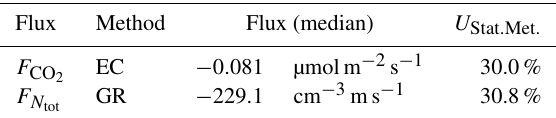
Table 1. Estimated relative expanded uncertainties for the fluxes of gaseous CO 2 and nanoparticles using the GR method, and for CO 2 using the EC method under stationary meteorological condi- tions ( U Stat . Met . ). More details on the uncertainty budget are pre- sented in Table S1. The uncertainty values are given at the median flux